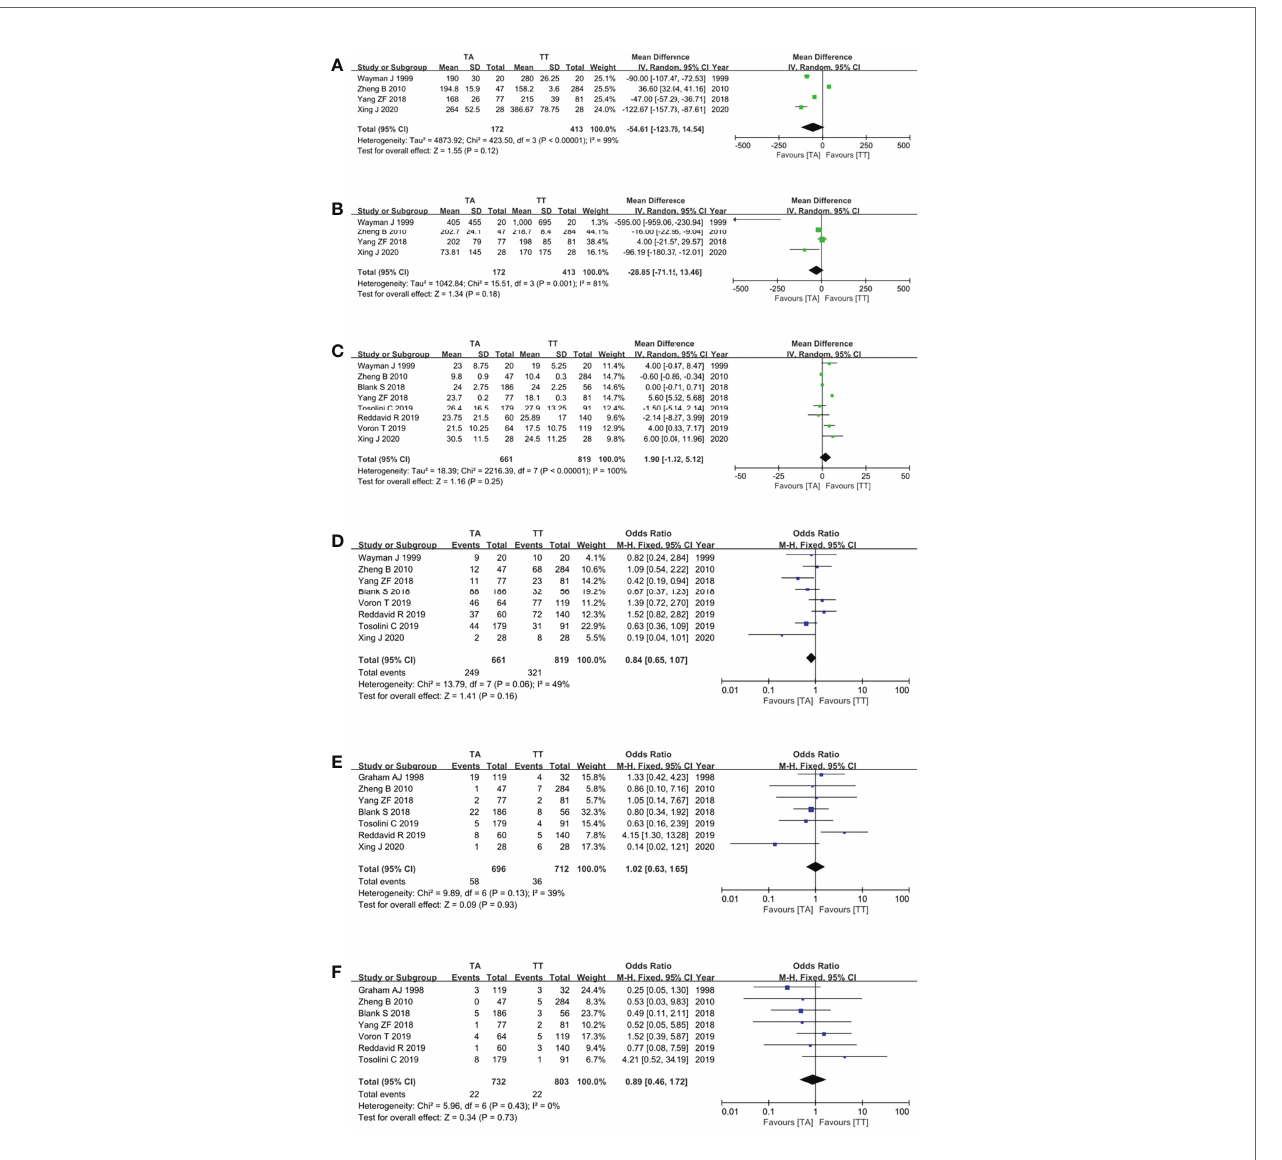
FIGURE 4 | Forest plots showing the assessment of surgical outcomes, namely, (A) operative time, (B) intraoperative blood loss, (C) the number of dissected lymph nodes, (D) postoperative complications, (E) anastomotic leakage rate, and (F) postoperative death rate. TA, transabdominal; TT,